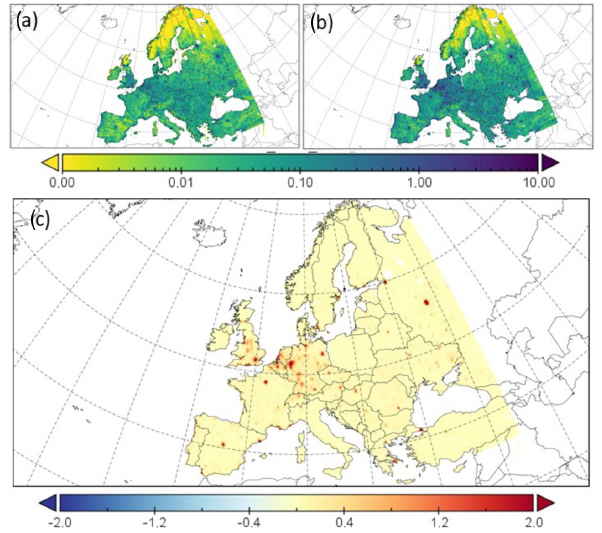
Figure 12. Future (2031–2050) premature deaths for (a) the miti- gation scenario with the population kept at present levels (REN80- P2010) and (b) the mitigation scenario that considers the population projections for 2050 (REN80-P2050). (c) Differences between both future scenarios (REN80-P2050 minus REN80-P2010). All values are in PDkm − 2